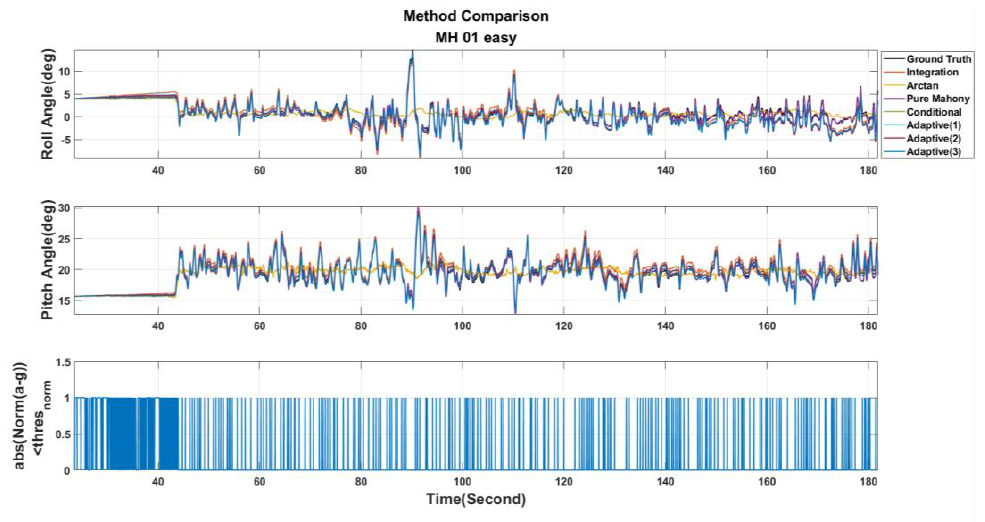
Figure 11. Roll and pitch angle obtained from different adjustment strategies for MH_01_easy series.